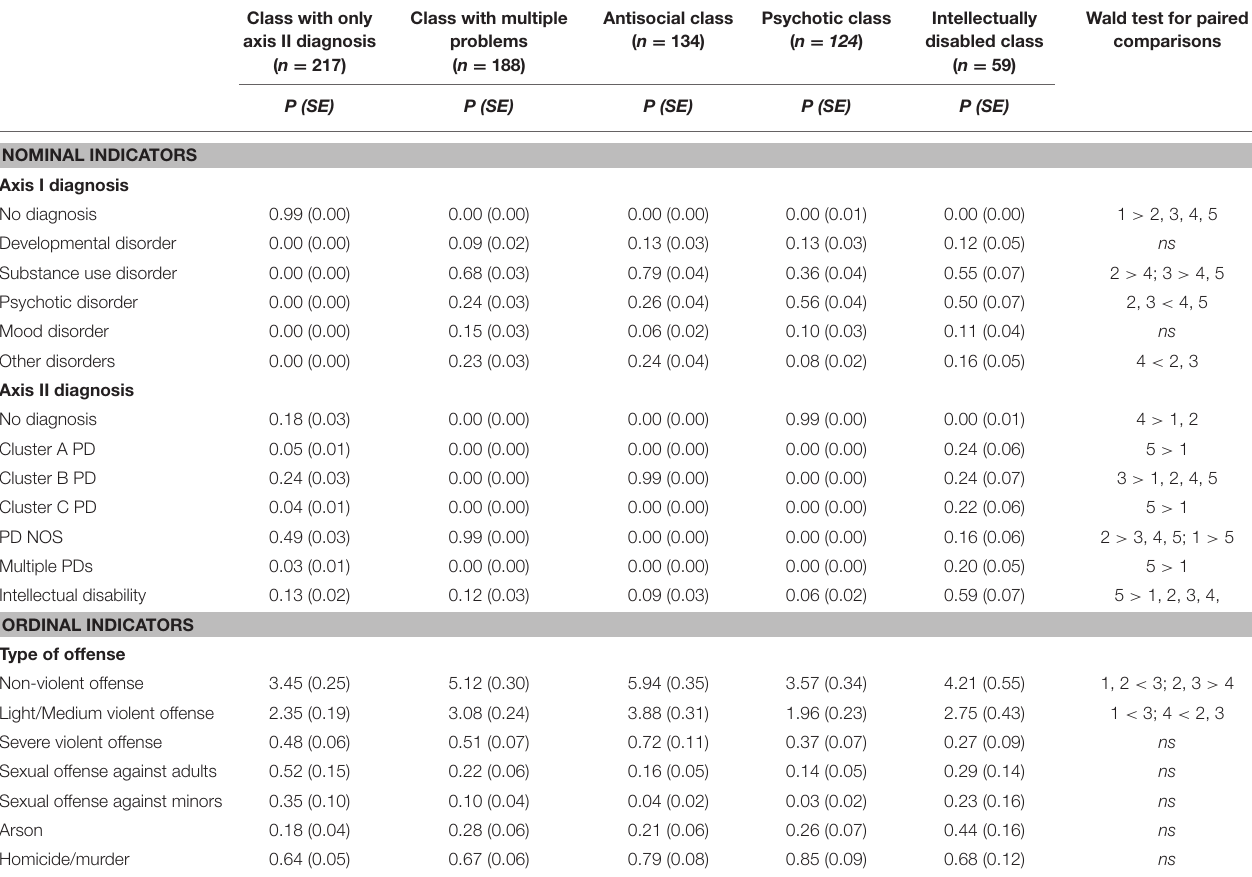
TABLE 4 | Class-specific probabilities/means of the psychopathology and type of